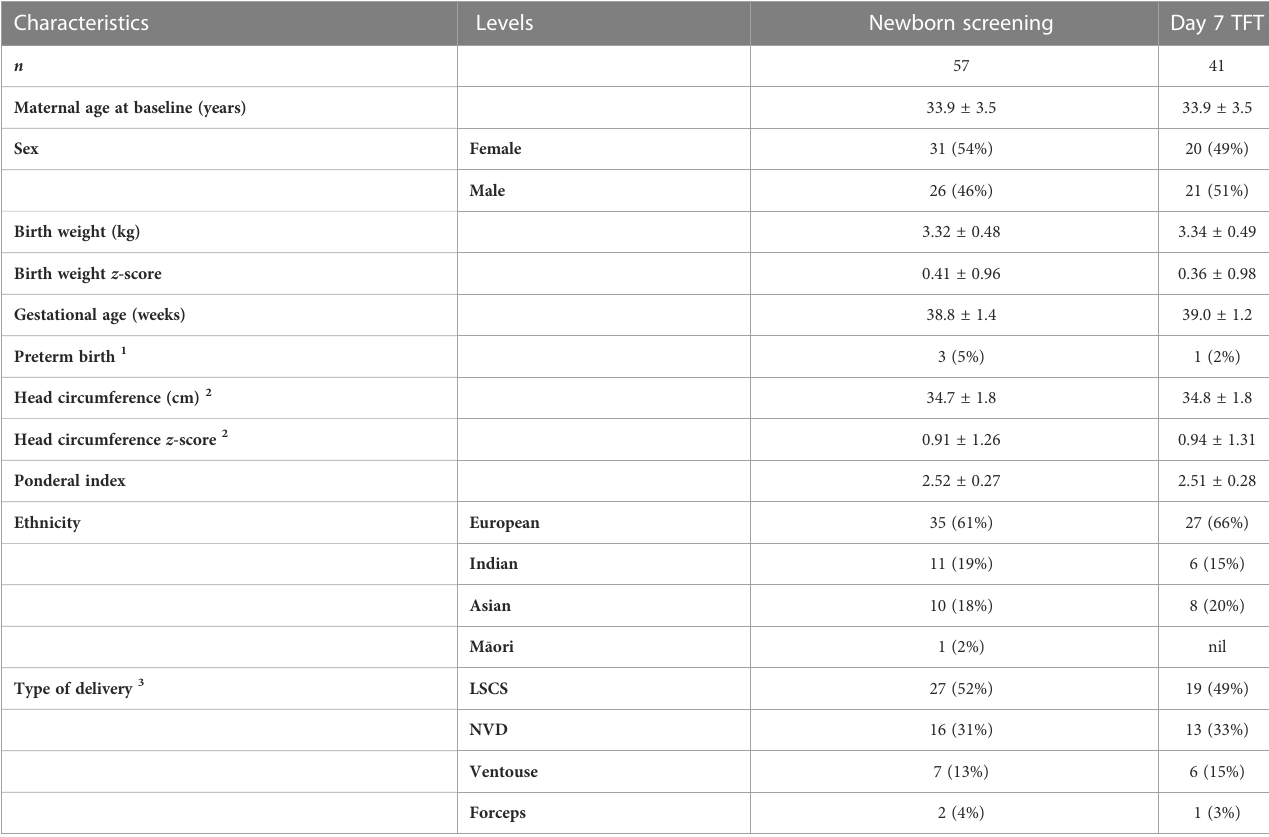
TABLE 1 Demographic and clinical characteristics of the offspring born in the SELFI study who were screened under the New Zealand newborn metabolic screening programme and those who also had a thyroid function test (TFT) at Day 7.